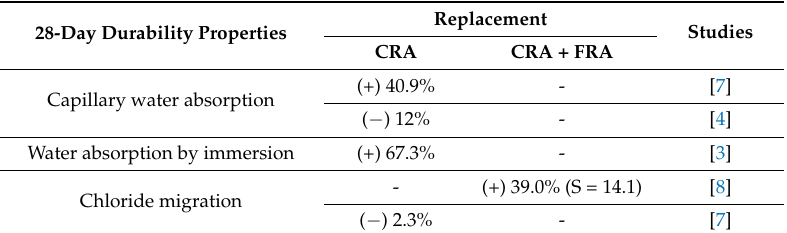
Table 3. CRA and FRA’s influence on SCC 28-day durability performance in different